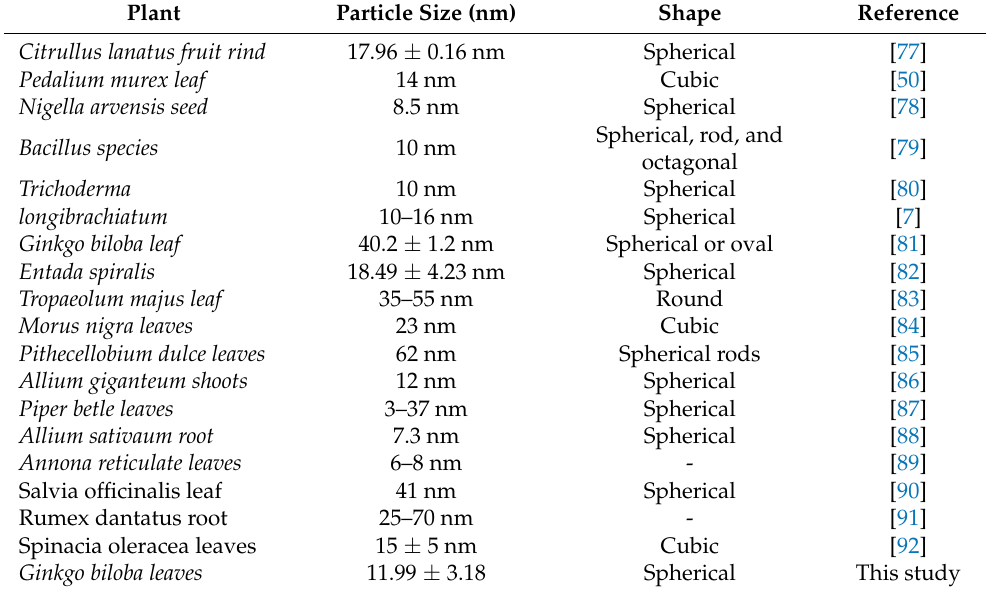
Table 4. The biofabricated Ag NPs using some plant sources with particle sizes and shapes.